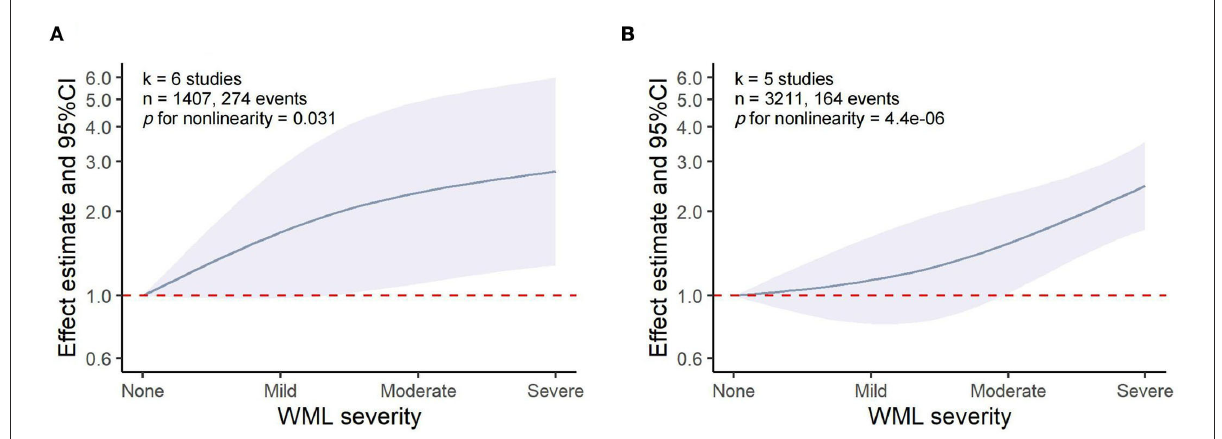
FIGURE5 Dose–response meta-analysis of the association between WML and HT/sICH. (A) WML severity and HT. (B) WML severity and